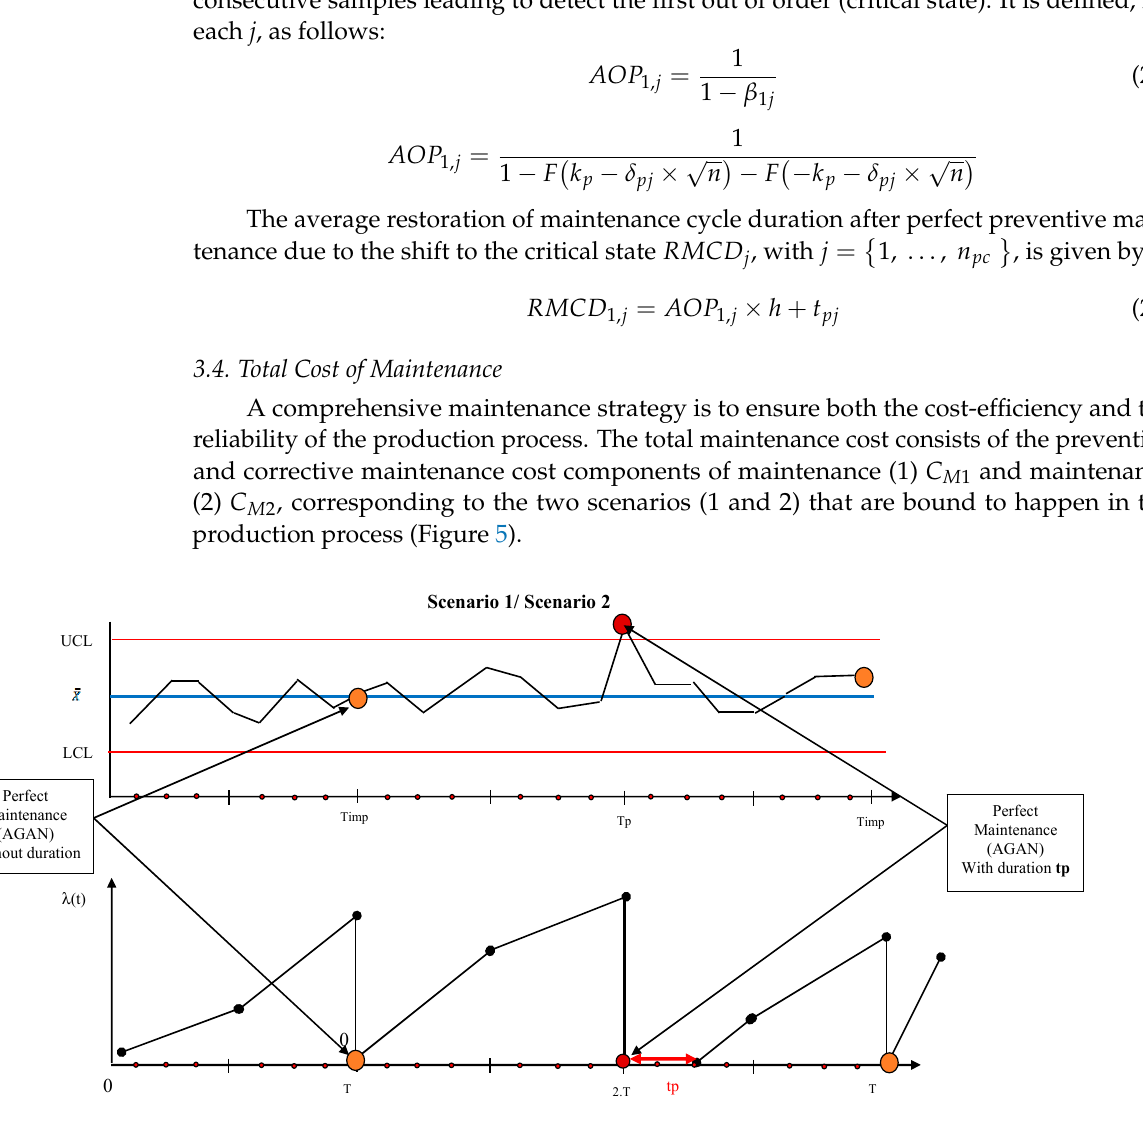
Figure 5. Integrated maintenance and control chart decision.